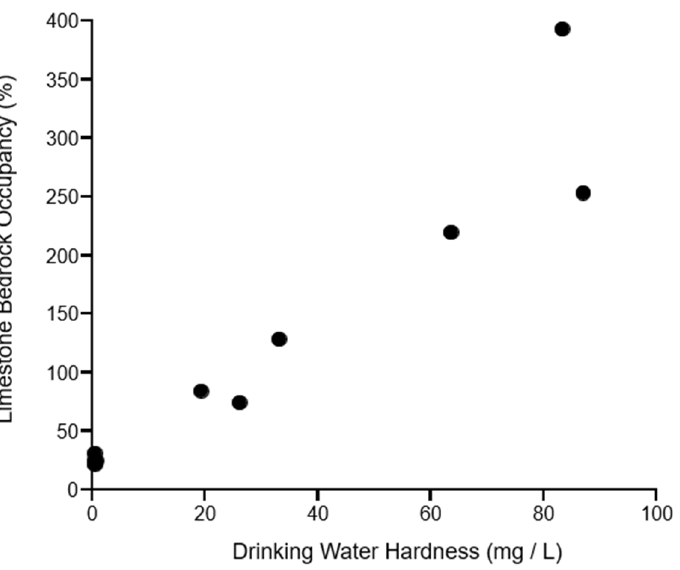
Figure 3. Relationship between limestone bedrock occupancy (LBO) and average of drinking water hardness (DWH) by island municipality. Black dots (n = 11) are plotted from municipal LBOs and DWHs.